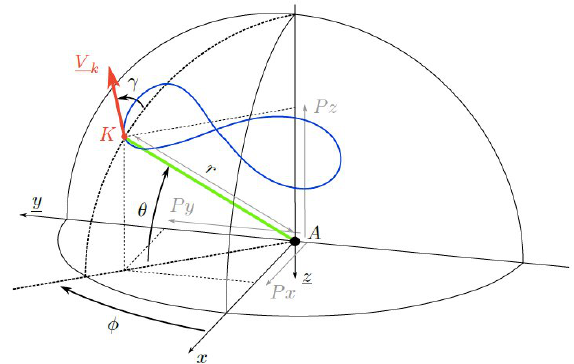
Figure 1. Drawing of the two kite positioning systems: cartesian or spherical. The axis system used for positioning the kite can vary depending on application.